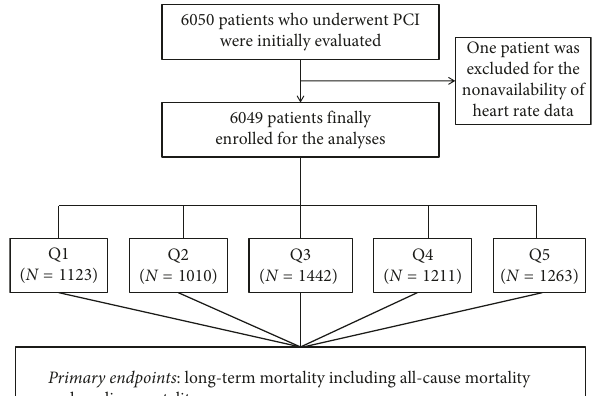
Figure 1: The flowchart of participant’s